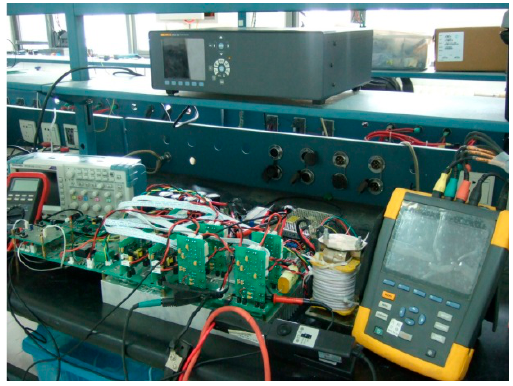
Figure 20. Prototype and its testbed.